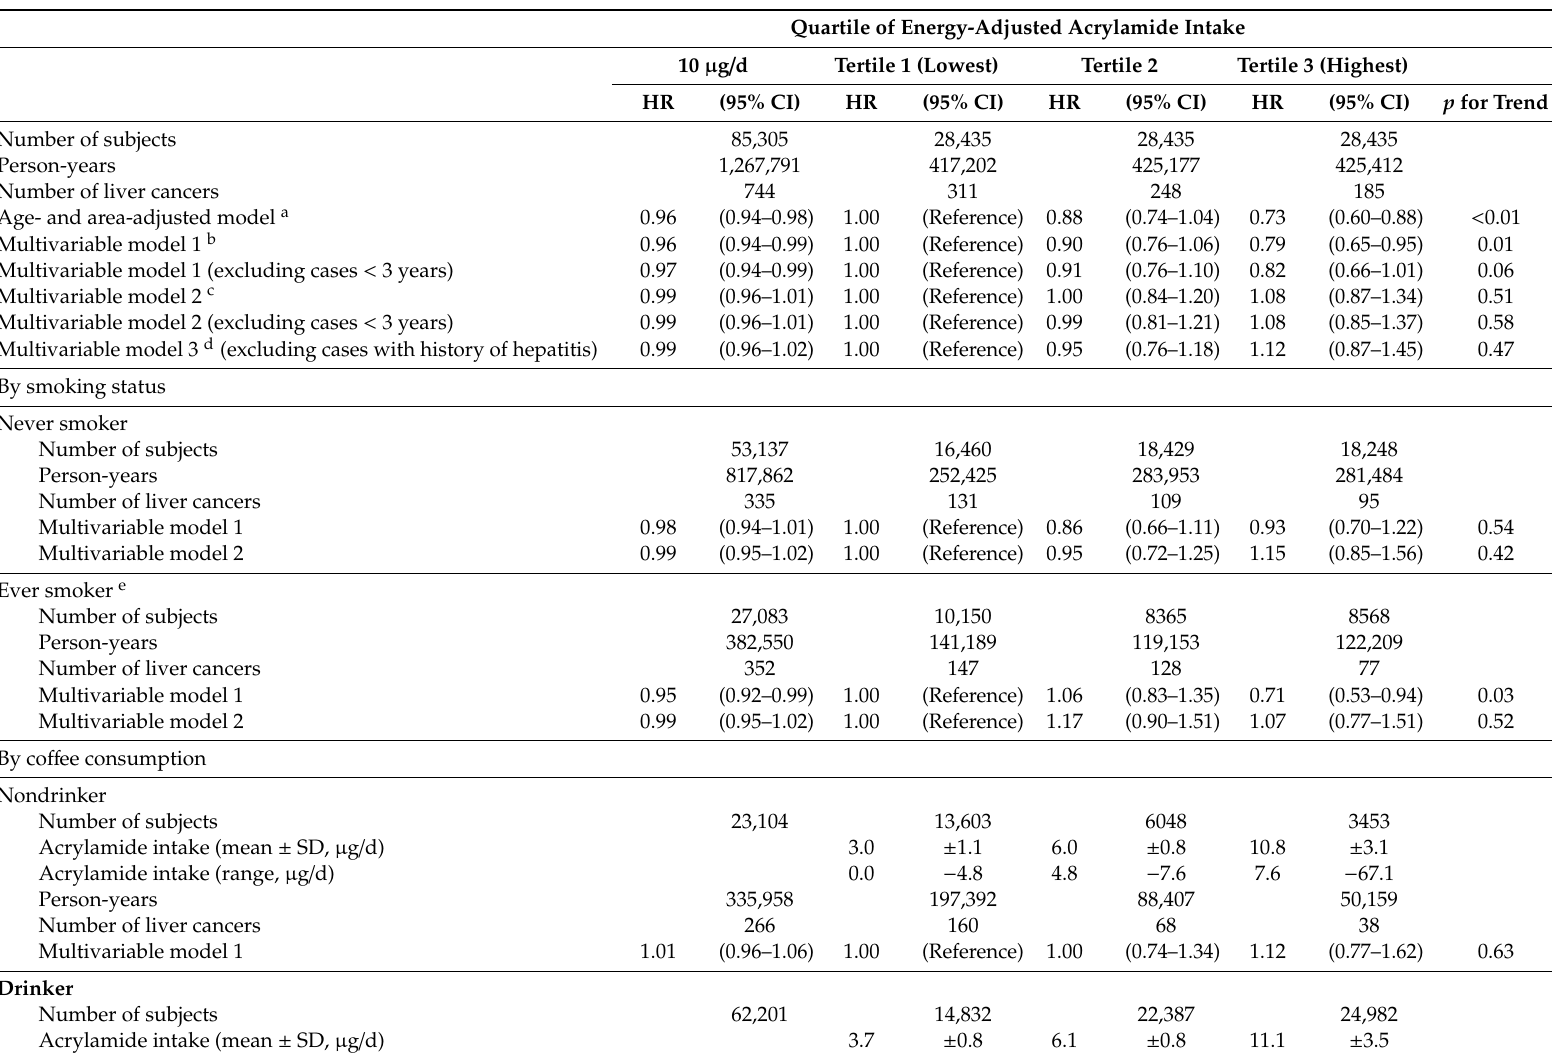
Table 2. Hazard ratios (95% confidence intervals) for liver cancer according to tertile of acrylamide